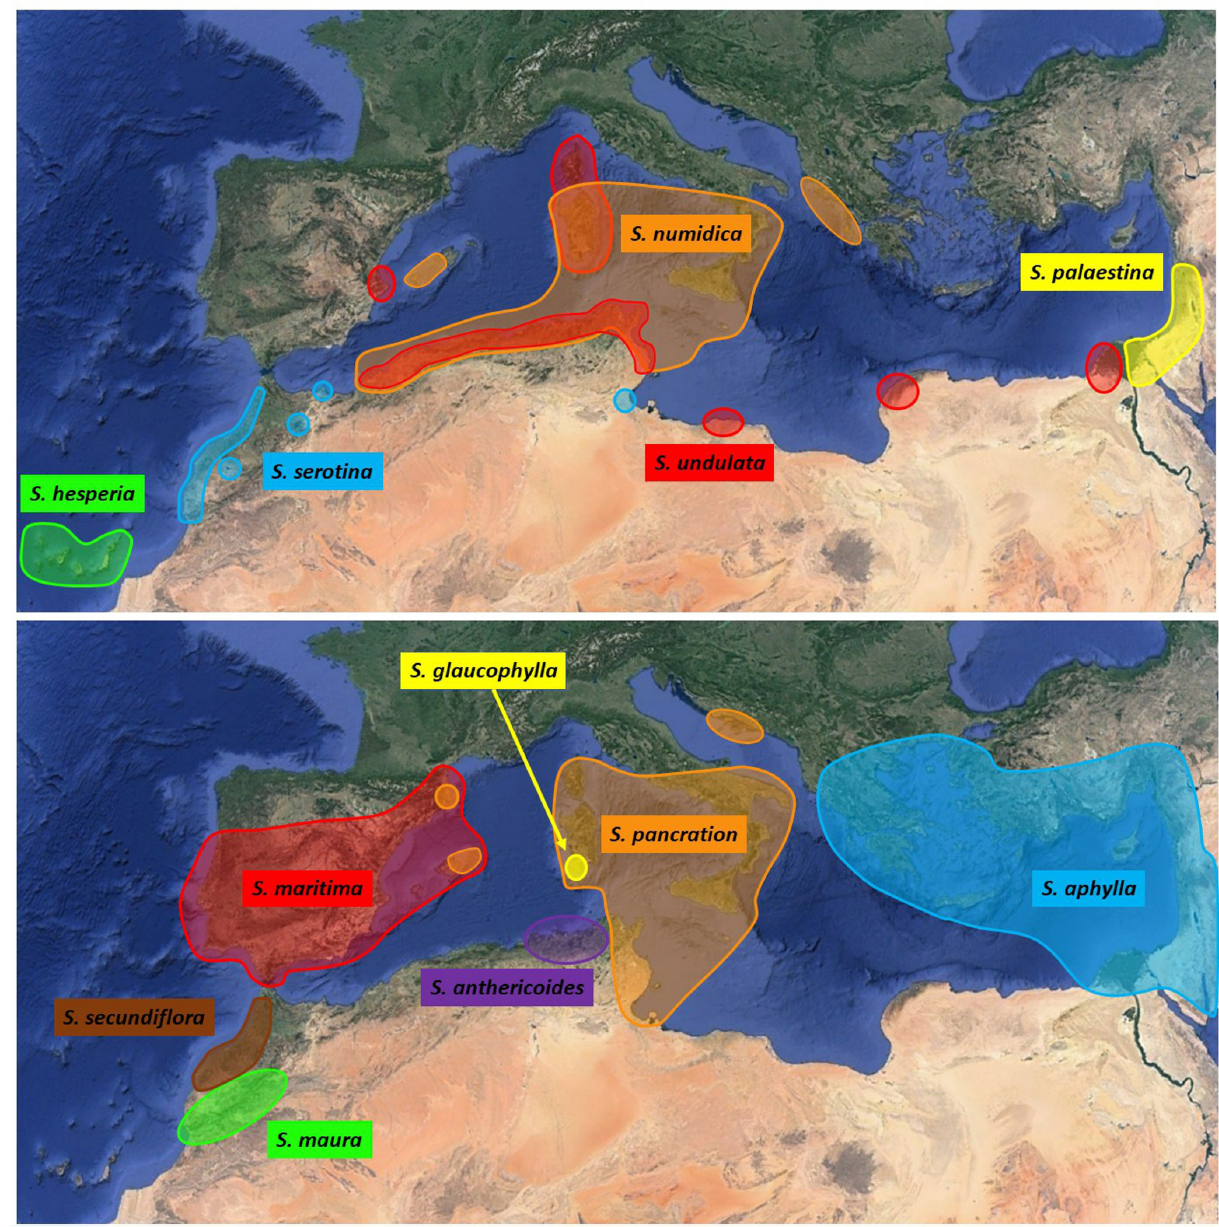
Figure 2. Distribution maps of Squilla species in the Mediterranean Basin and Canary